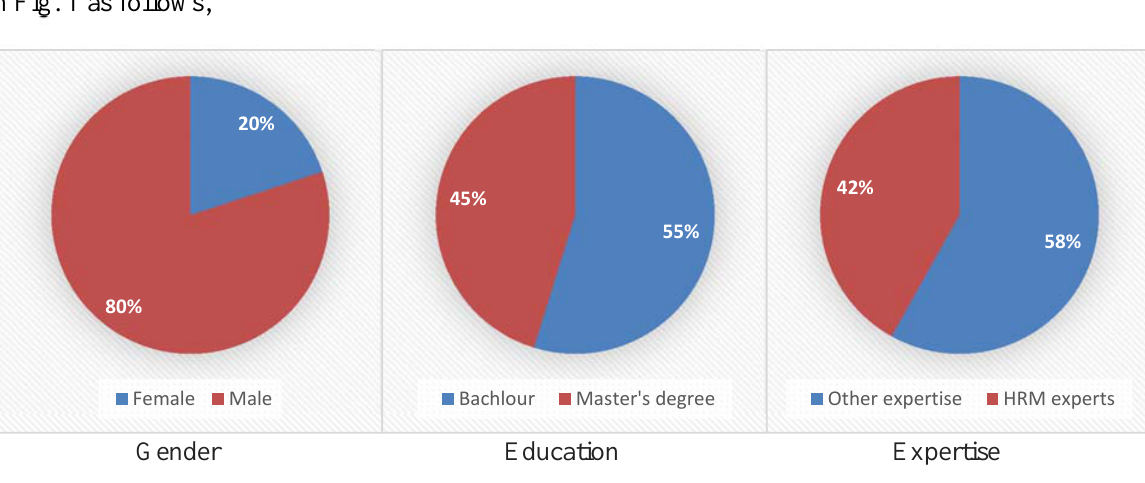
Fig. 1. Personal characteristics of the